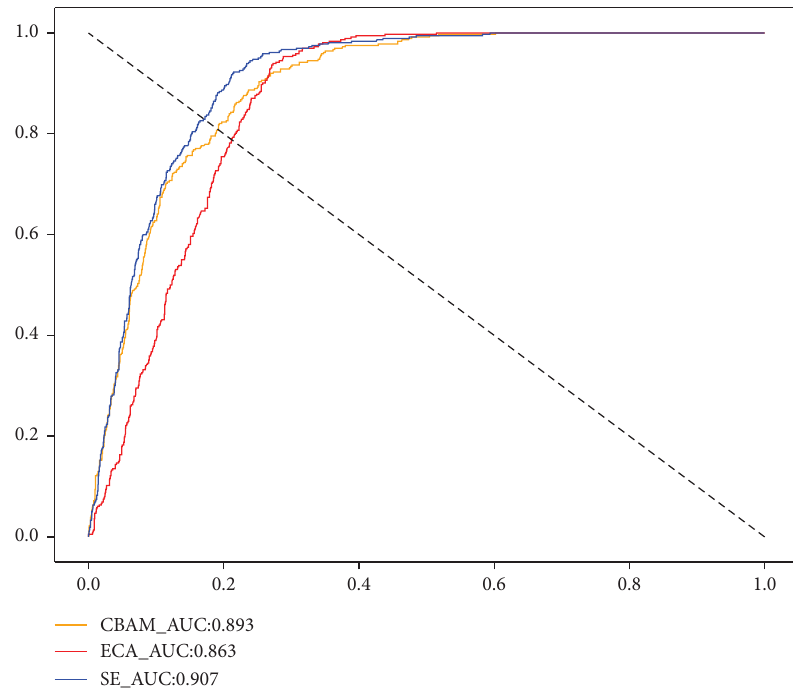
Figure 12: Reconstruction method results in diferent attention mechanisms.